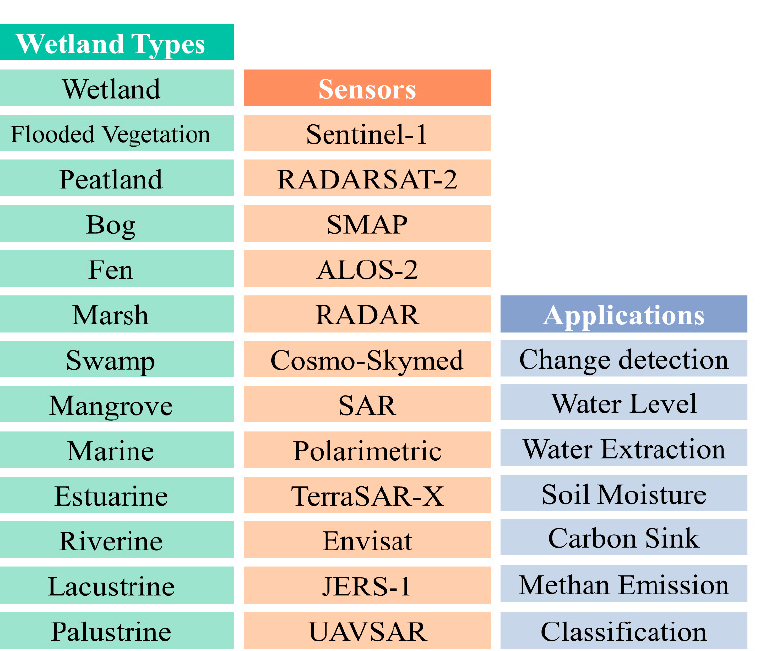
Figure 2. Designated search query and corresponding search phrases for wetland mapping review using SAR data. Key terms in the first and second columns were imported as an input in the topic section and the last column in the title.